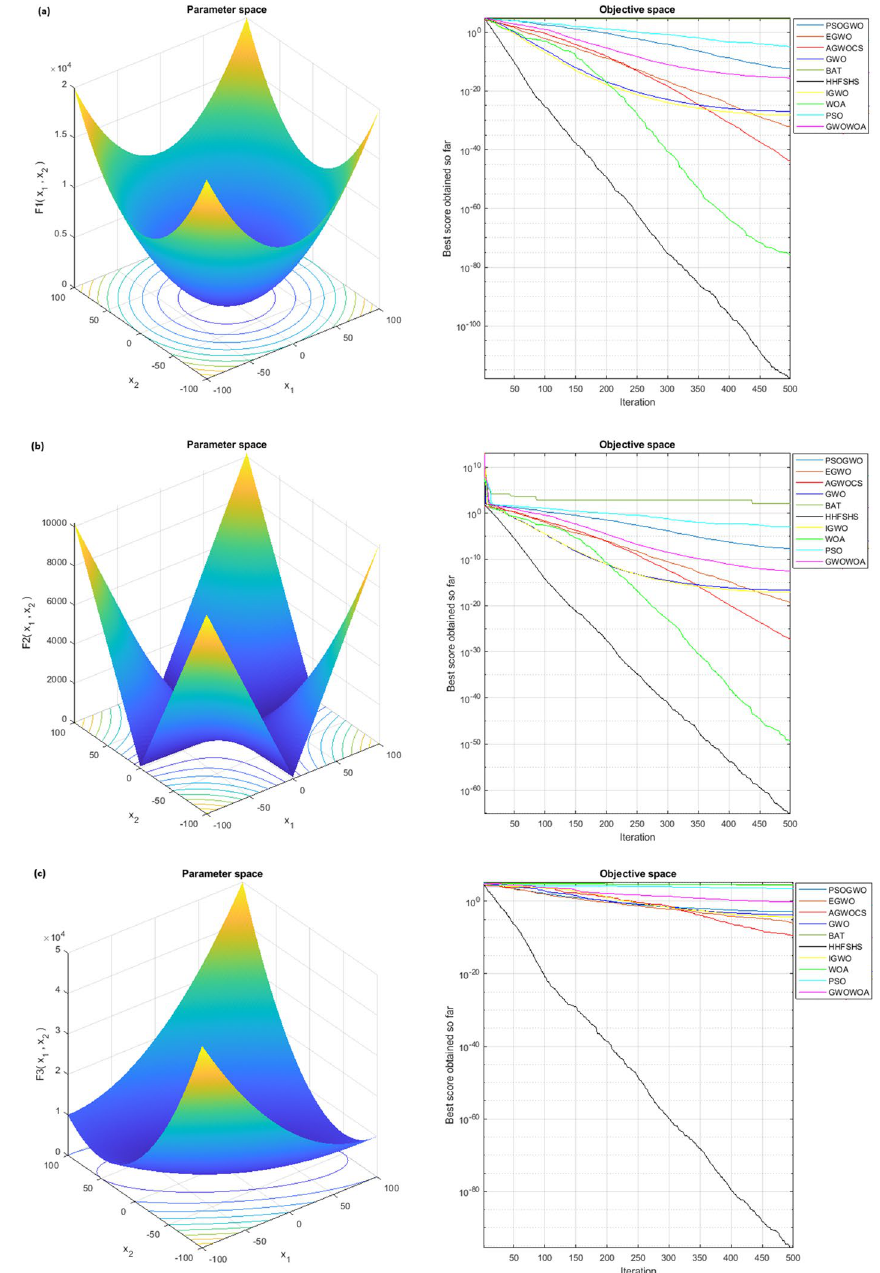
Fig. 5 HHFSHS algorithm Convergence comparison with other